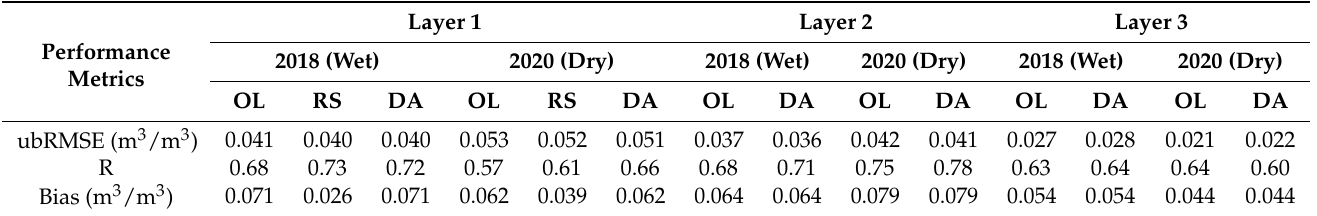
Figure 8. Soil moisture values of open loop model, in-situ observations and SMAP observations at four in-situ measurement stations in 2018 ( top row ) and 2020 ( bottom row ). Table 2. Unbiased root-mean-squared-error (ubRMSE), correlation coefficient (R), and bias calculated between in-situ soil moisture observations and open loop model runs (OL), remotely sensed SMAP data (RS), and post-assimilation model runs (DA).